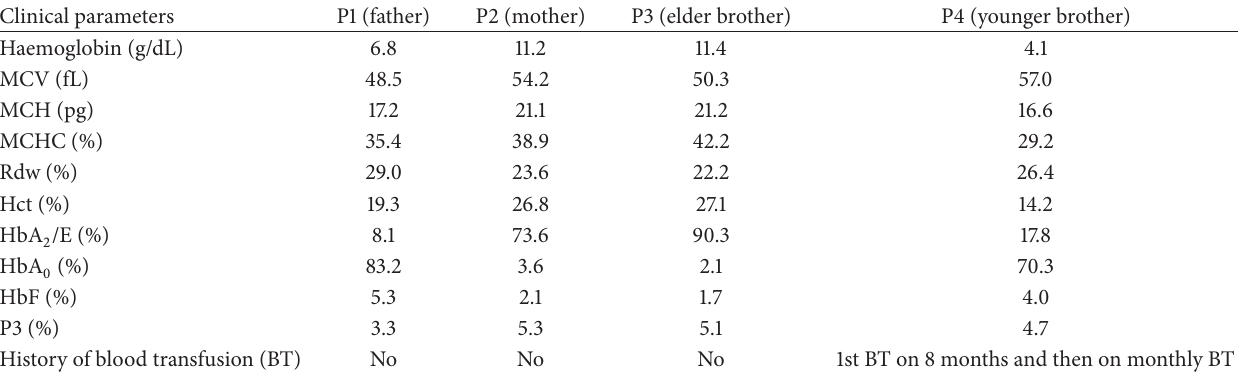
Table 1: Clinical data of the members of the family in study.